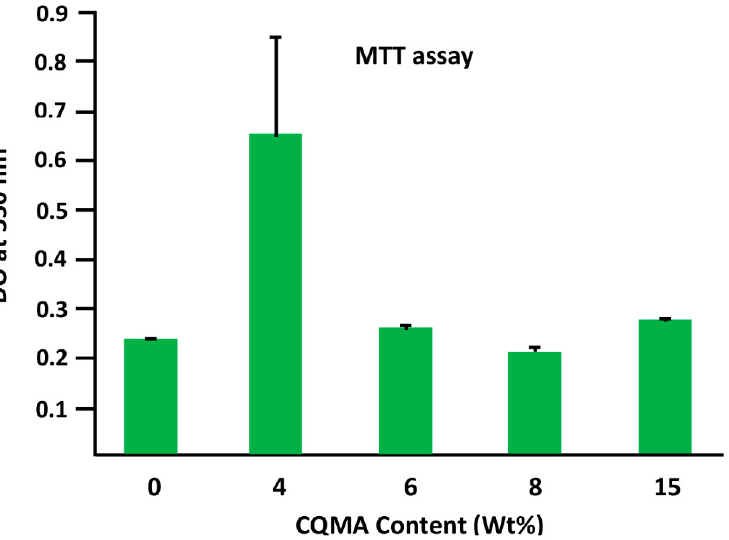
Figure 14. The effect of HCQ content in the CQMA-co-HEMA drug carrier system on Ca9-22 cell adhesion.